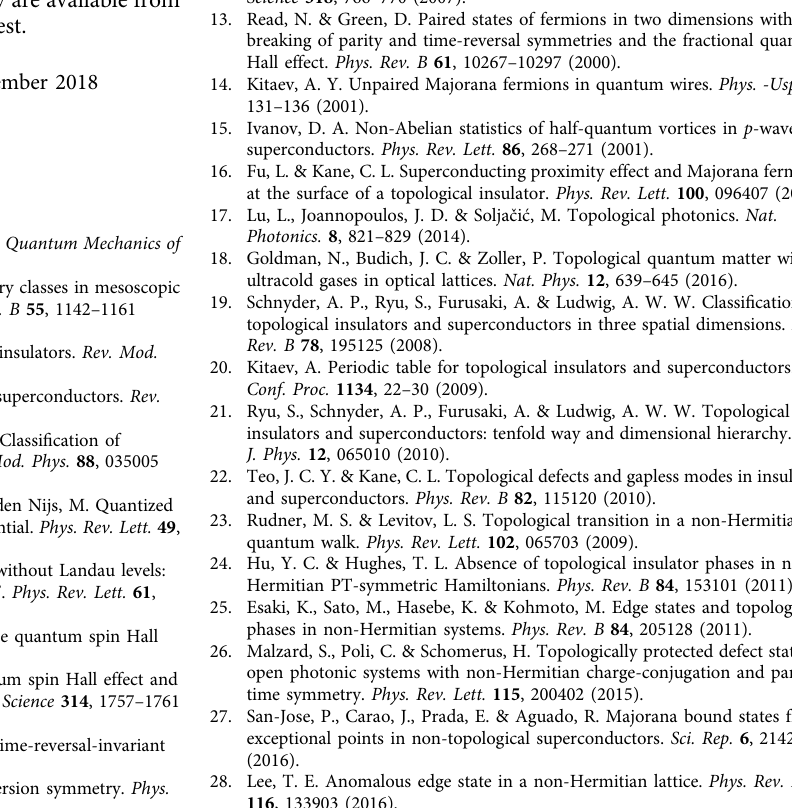
= 0). No gapless states appear between the gapped complex AII